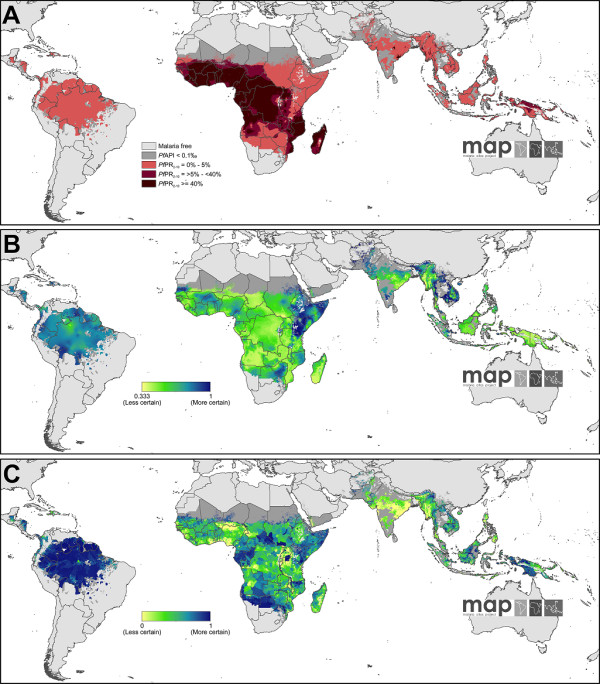
The Spatial distribution of Plasmodium falciparum malaria PfPR2-10 in 2010 stratified by endemicity class [2], and associated uncertainty. Panel A shows predictions categorized as low risk PfPR2-10 ≤5% light red; intermediate risk PfPR2-10 > 5% to < 40%, medium red; and high risk PfPR2-10 ≥40%, dark red. The map shows the class to which PfPR2-10 has the highest predicted probability of membership. The rest of the land area was defined as unstable risk (medium grey areas, where PfAPI < 0.1 per 1,000 pa) or no risk (light grey). Panel B shows the probability of PfPR2-10 being in the class to which it was assigned as a yellow to blue continuum from 0.3˙-1. Any value above 0.3˙ is better than a chance allocation. Panel C shows the population-weighted index of uncertainty. This index shows the likely importance of uncertainty assessed by the product of the log of population density and the reciprocal of the probability of correct class assignment, rescaled from 0-1 to correspond to Panel B so that least uncertain areas have higher values in blue and most uncertain have lower values in yellow. The index is shown for the most probable PfPR2-10 endemicity class.